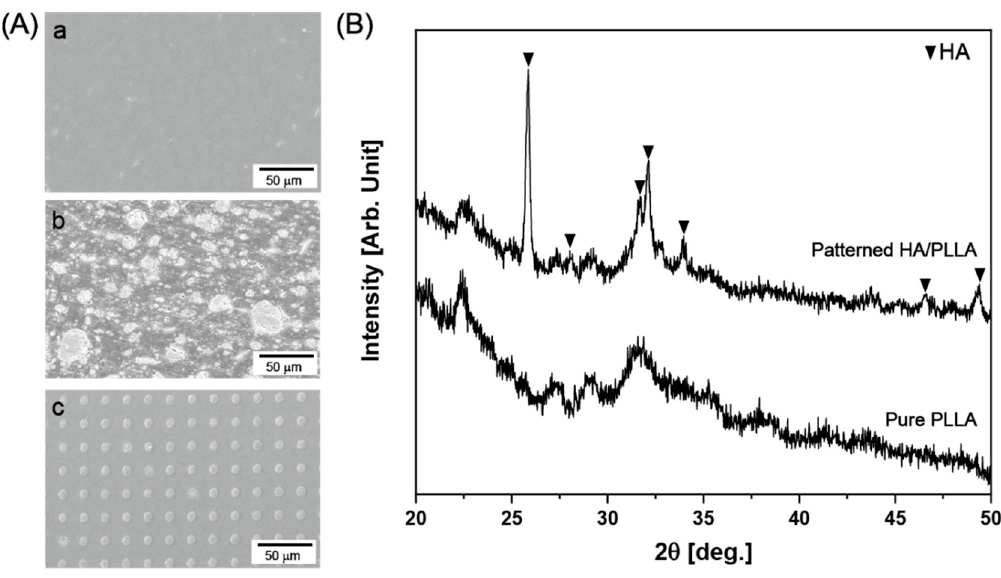
Figure 2. ( A ) SEM images of (a) pure PLLA, (b) HA/PLLA, and (c) patterned HA/PLLA. ( B ) XRD spectra of pure PLLA and patterned